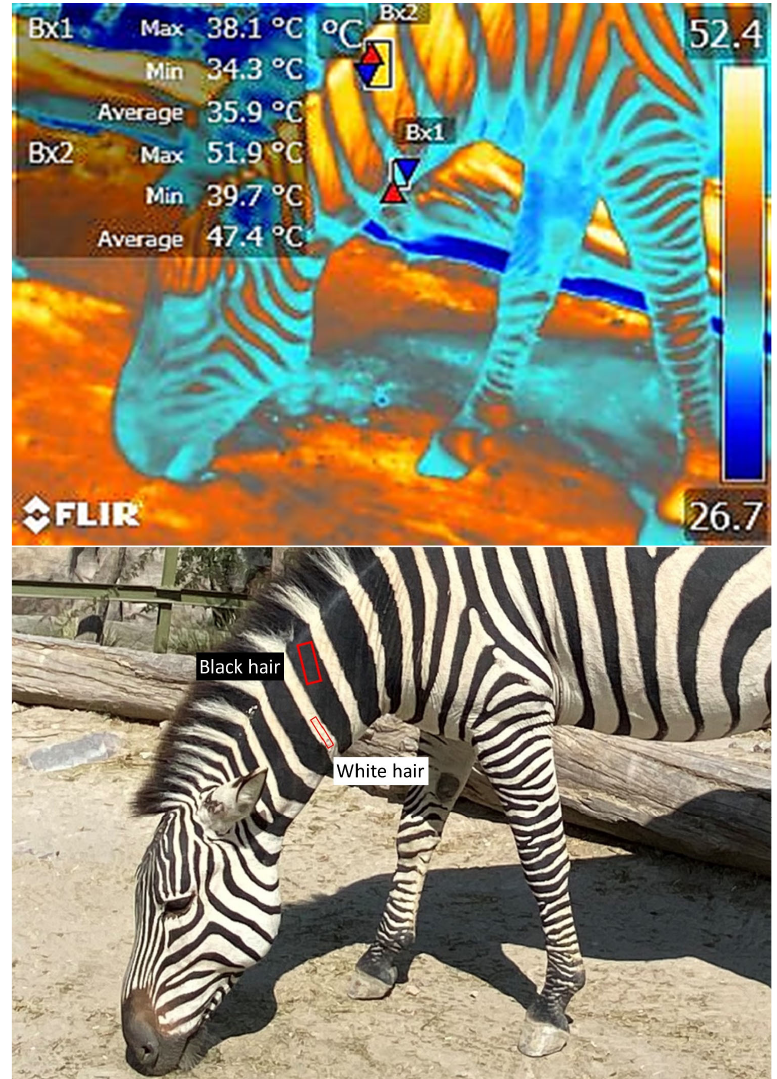
Figure 11. Effect of coat color on the surface temperature of a zebra ( Equus quagga ). It has been suggested that the zebra’s stripes play a role in thermoregulation. IRT images show that the average temperature of the white stripes in the neck is 35.9 ◦ C (Bx1), while the average temperature of the zone with black hair is 47.9 ◦ C (Bx2), a difference of 11 ◦ C. This evidence reaffirms the importance of considering hair color in some species when using IRT since it can influence the amount of solar radiation that may be absorbed. (Radiometric images and photographs by the